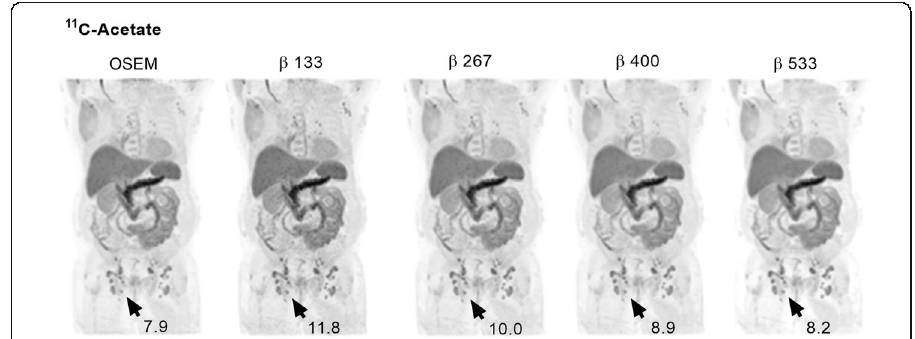
Fig. 7 Coronal whole-body 11 C-acetate PET images of a patient with soft tissue prostate cancer metastases. Images were acquired 11 min post-injection and reconstructed with 3 min/bed using OSEM (3 iterations, 16 subsets, 5-mm Gaussian post-processing filter) and BSREM with β -values of 133, 267, 400, and 533. Both reconstruction methods included TOF and PSF recovery. The administered activity was 4.2 MBqkg − 1 . The SUV max of the lesion (arrow) is shown for the respective